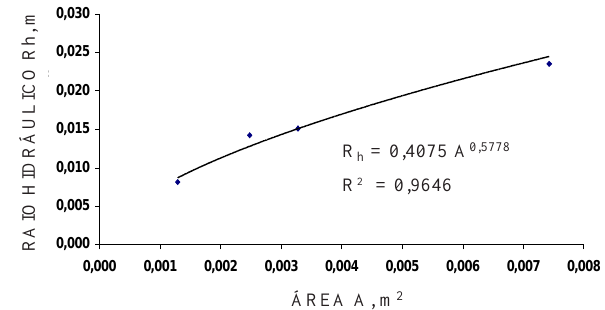
Figura 2. Variação do raio hidráulico de acordo com a área da seção transversal dos sulcos pré- formados no solo franco-argilo-arenoso recém- preparado, ajustada ao modelo de potência para os fluxos extras aplicados ao escoamento superficial gerado pela chuva simulada.